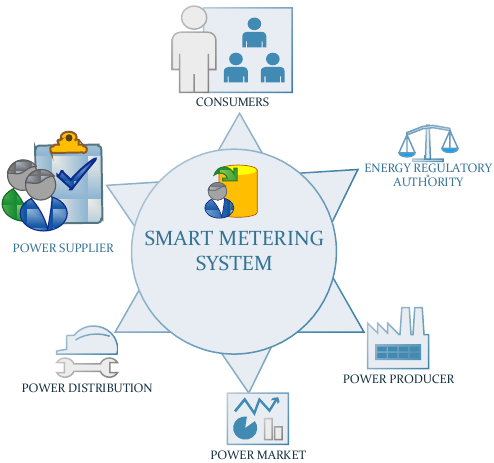
Figure 1. Stakeholders involved in smart metering